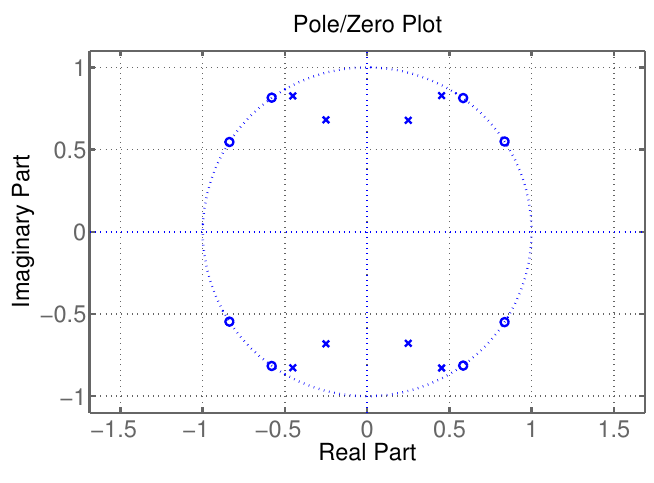
Figure 13. Pole-zero plot of HP IIR filter.